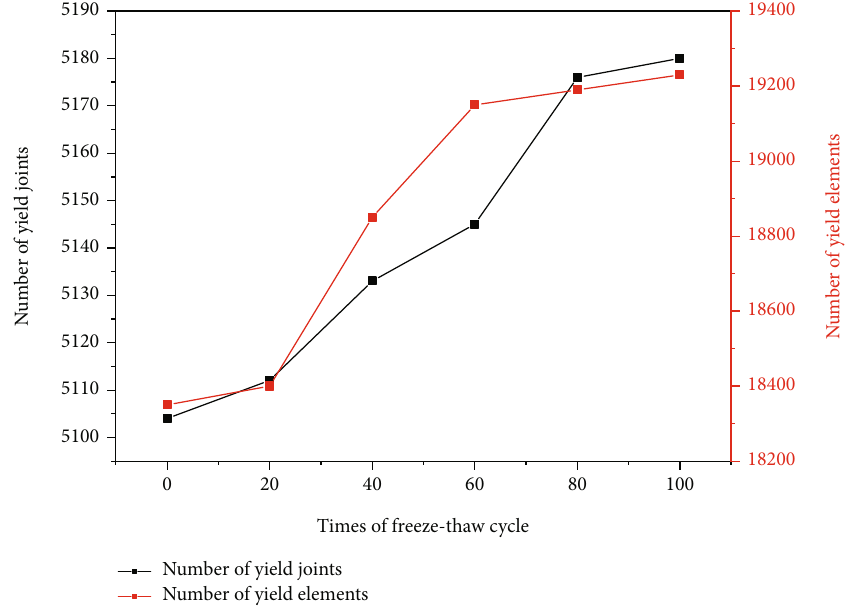
Figure 17: Number of yield elements and yield joints of slope